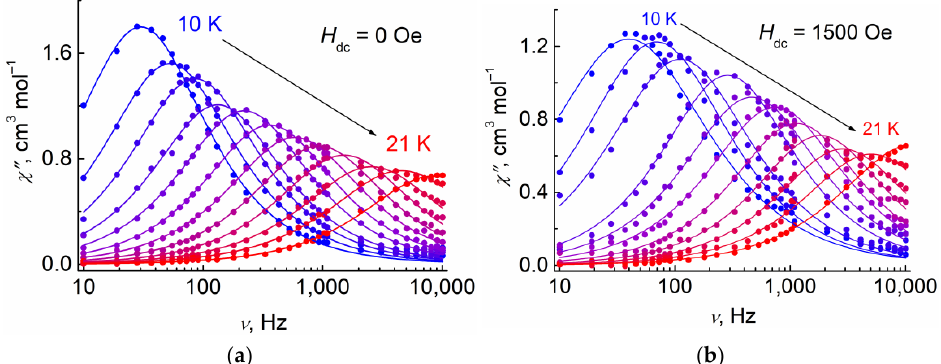
Figure 4. Frequency dependences of the out-of-phase ac susceptibility signals for complex 1 at zero ( a ) and 1500 Oe ( b ) dc fields. Dots are experimental data; lines are fits with the generalized Debye